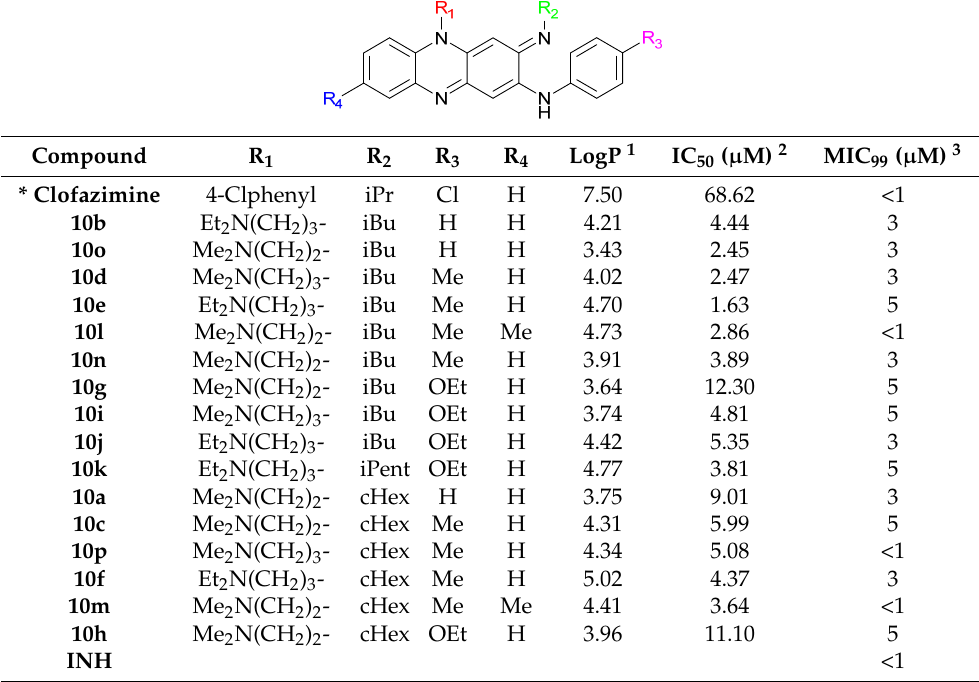
Table 1. Structure–activity assessment of riminophenazines 10 .